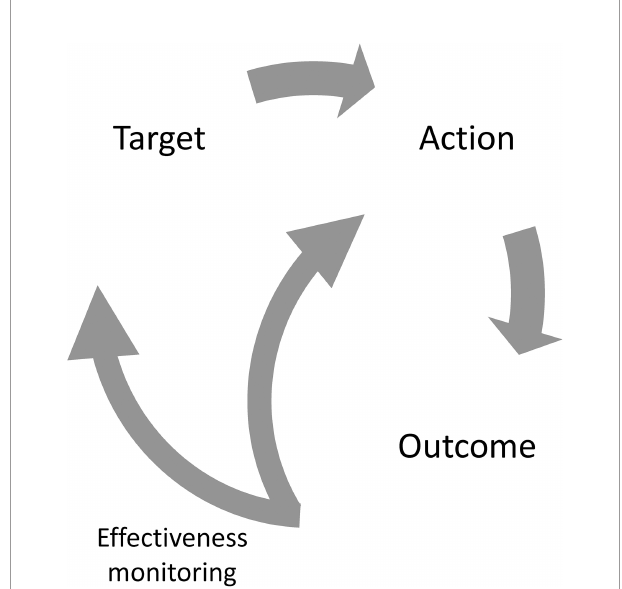
FIGURE 2 | Flow diagram depicting the cycle of targets, actions, outcomes, and monitoring. The CBD ’ s goals correspond to major desired outcomes such as halting anthropogenic species extinctions. The associated targets correspond to categories of conservation actions (e.g., protection of 30% of land and waters) designed to reduce direct and indirect drivers of biodiversity loss. Each target incentivizes and guides conservation actions to address major drivers of biodiversity loss. If targets are met by all CBD parties, this will collectively result in achievement of desired biodiversity outcomes. Compliance and effectiveness monitoring is necessary to ensure that a) nations are implementing proposed actions, and b) such actions result in expected outcomes, respectively. Results from such monitoring can inform revisions to the set of CBD targets and associated actions during the framework ’ s decadal